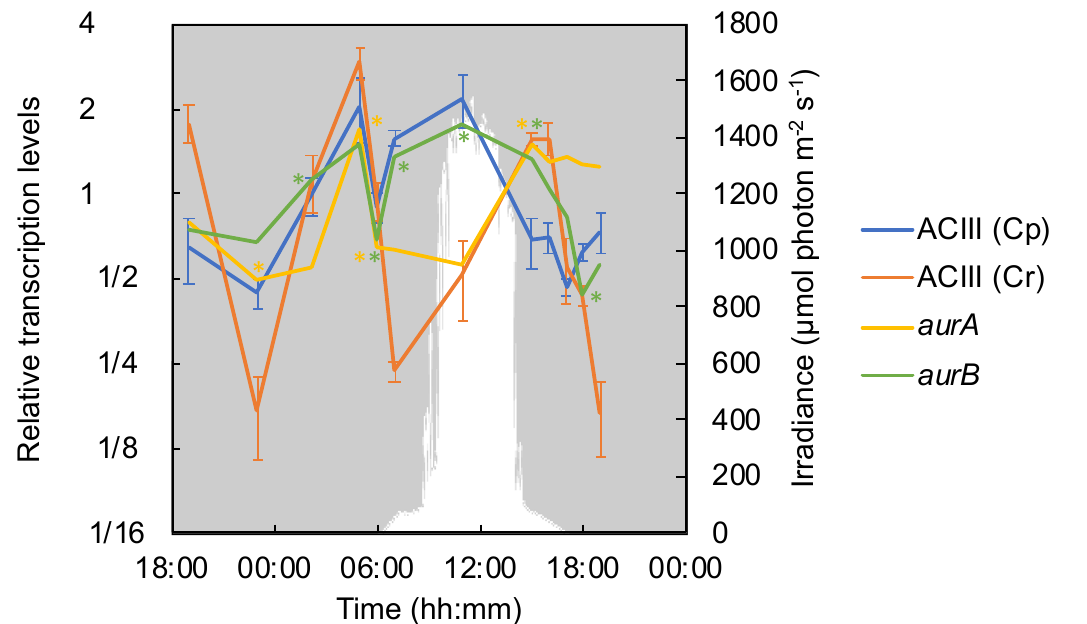
Figure 4. Relative transcriptional levels for alternative complex III (ACIII) and auracyanin. The mean values of ACIII (Cp, Cagg_3382–3383, and 3385–3387) for phototrophic electron transfer and ACIII (Cr, Cagg_1523–1527) for chemotrophic electron transfer are represented by a blue line and an orange line, respectively, with standard deviations. The values of aurA and aurB (Cagg_0327 and 1833) encoding auracyanin are respectively displayed as yellow ( aurA ) and green ( aurB ) lines. The downwelling photon irradiance (PAR; 400–700 nm) is indicated in white. The asterisk indicates the transcription of a particular gene corresponding to the color in a timepoint differed significantly from that in the previous timepoint.